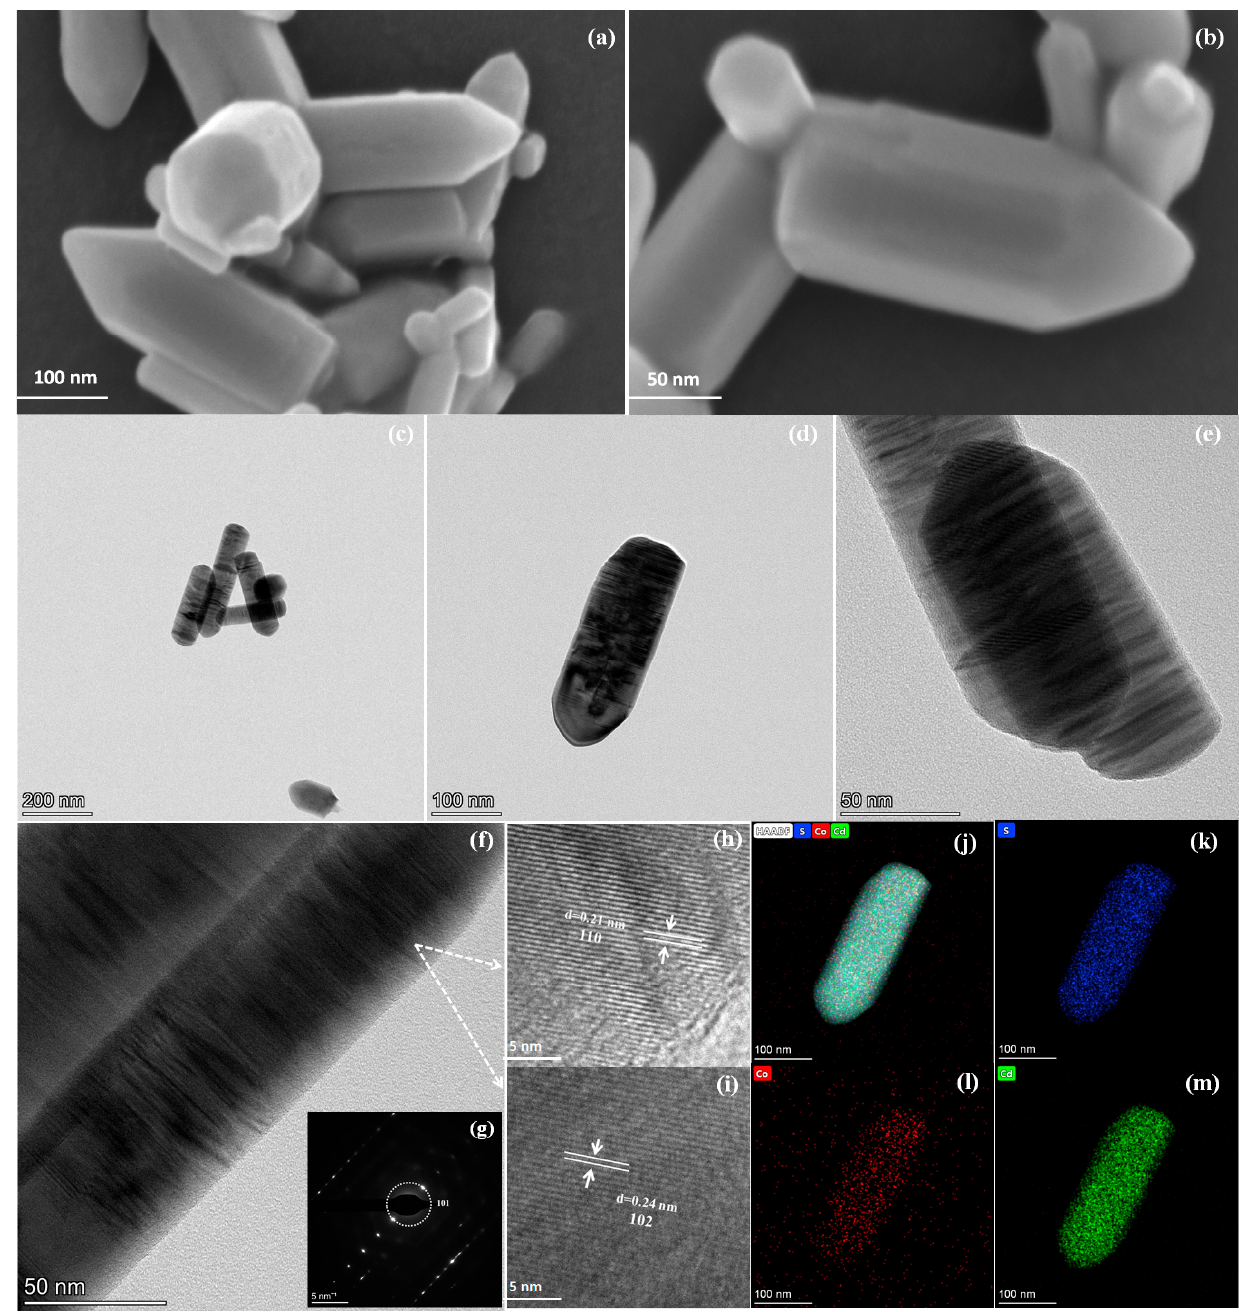
Figure 2. SEM images ( a , b ) and TEM images ( c – f ), SAED pattern ( g ), HRTEM images ( h , i ), and elemental mappings ( j – m ) of the Cd 0.9 Co 0.1 S NRs. elemental mappings ( j – m ) of the Cd 0.9 Co 0.1 S